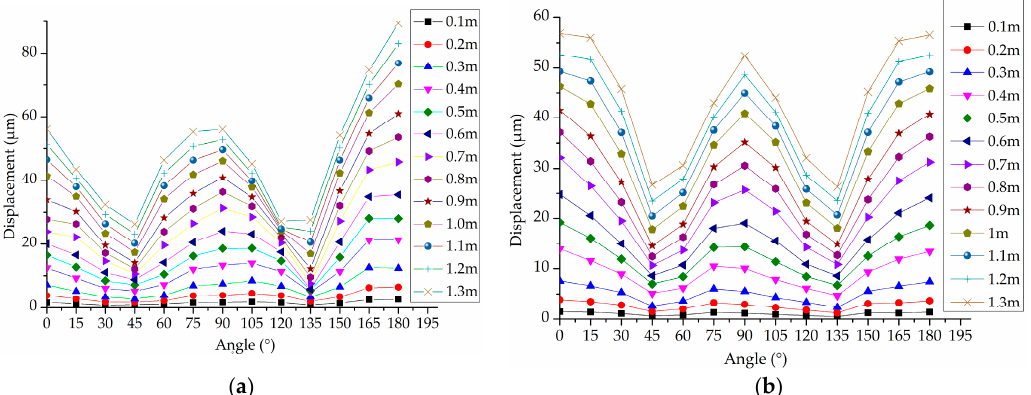
Figure 5. Displacement of the tower model under various direction angles for different tower heights. ( a ) Line 1, ( b ) Line